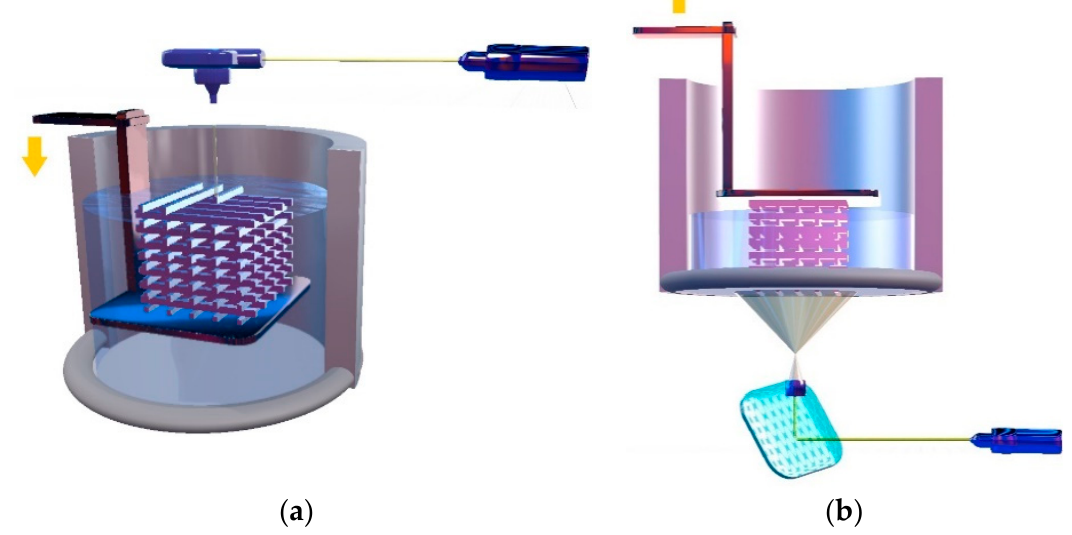
Figure 1. Schematic illustration of SLA approaches: ( a ) top-down; ( b ) bottom-up. In the bottom-up orientation (Figure 1b), the fabrication platform is dipped into the resin vat, whose bottom surface is transparent and non-adhering. The light is projected from underneath, initiating the photopolymerization of the resin film between the movable platform and the bottom of the vat. After the curing of the first layer, the platform moves up, and photopolymerization continues with a new layer, which is fabricated underneath the previous one. This technique allows the printing of high objects with the use of low resin volumes [61]. Additionally, the cured layers are not exposed to the atmosphere, so the inhibition of the photopolymerization reaction is prevented. Specific advantages of bottom-up techniques refer to smaller layer thickness, which can be accurately controlled by the elevator, higher vertical resolution and surface quality [59,62]. The common SLA 3D printer models are manufactured by Formlabs, 3D Systems, Full Spectrum Laser, Asiga,